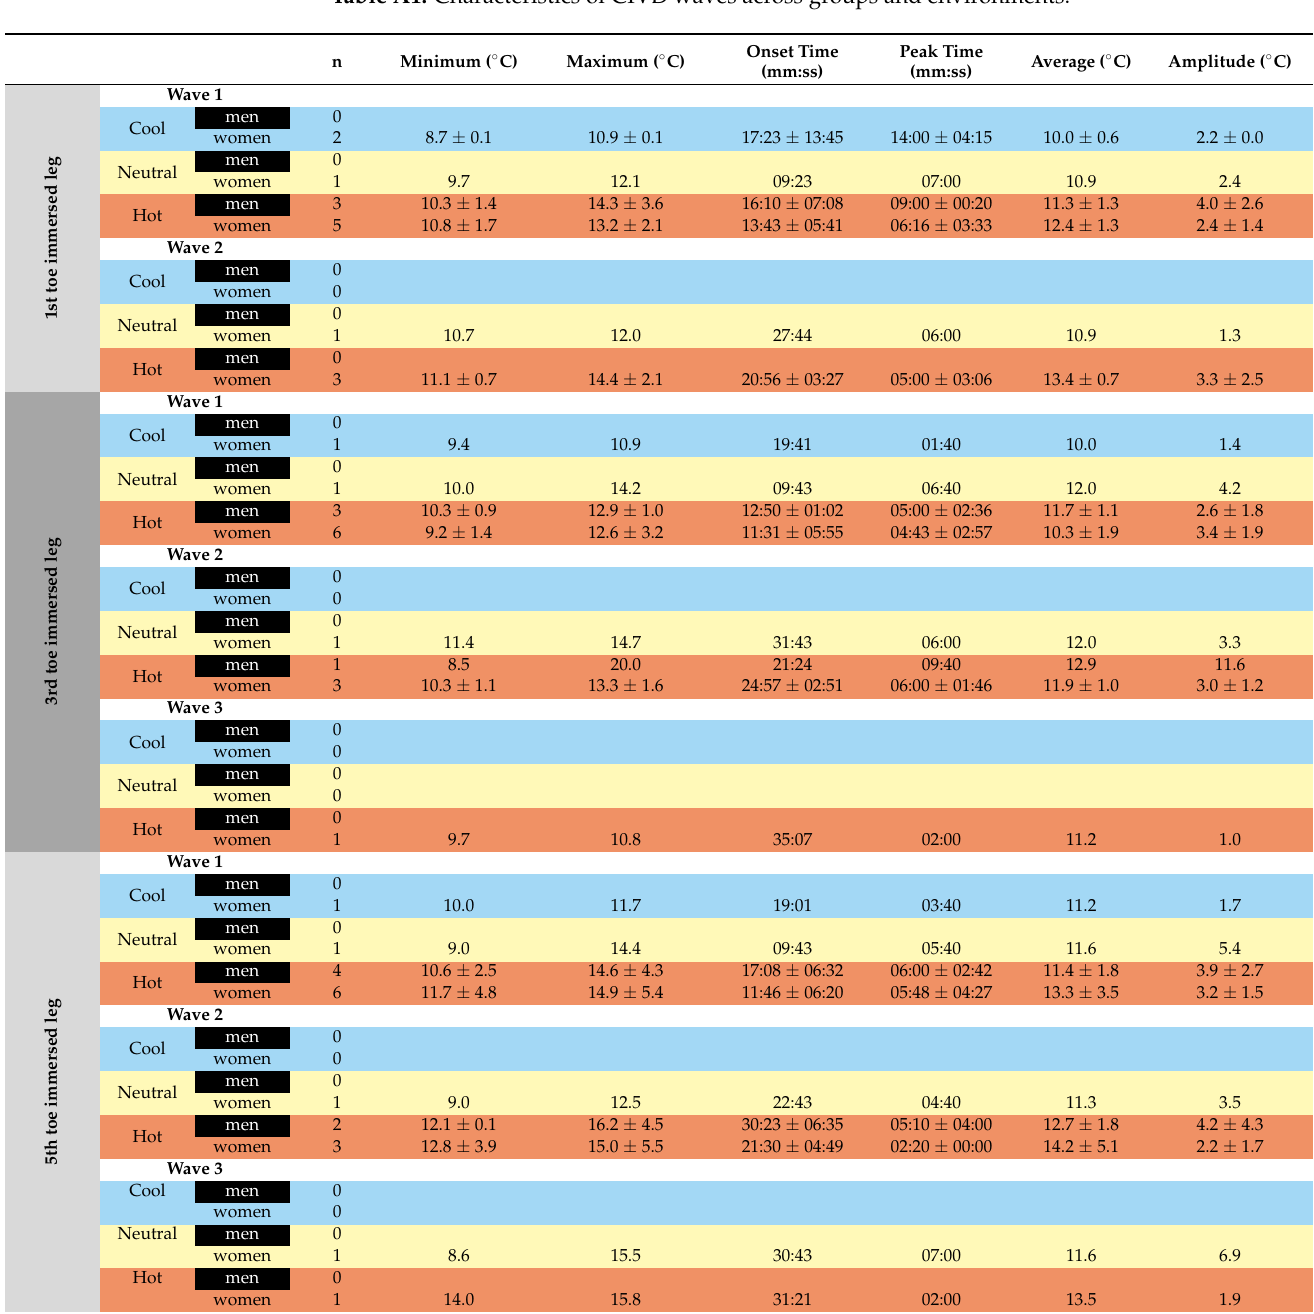
Table A1. Characteristics of CIVD waves across groups and